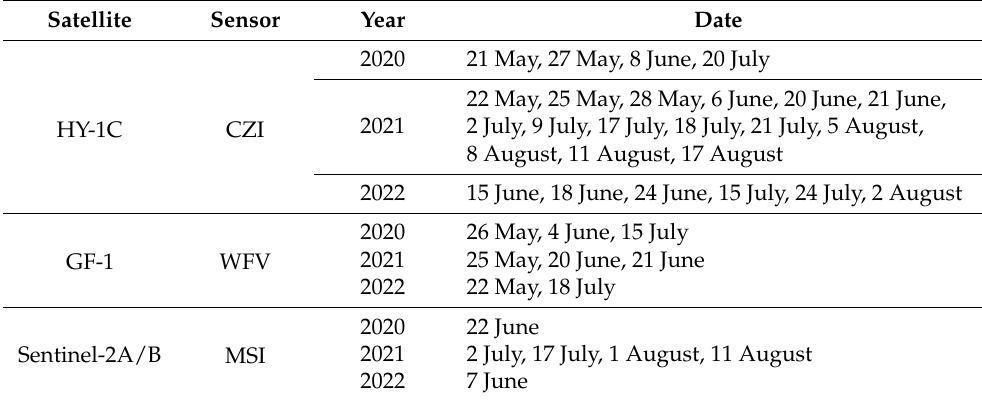
Table 1. The dates of remote sensing